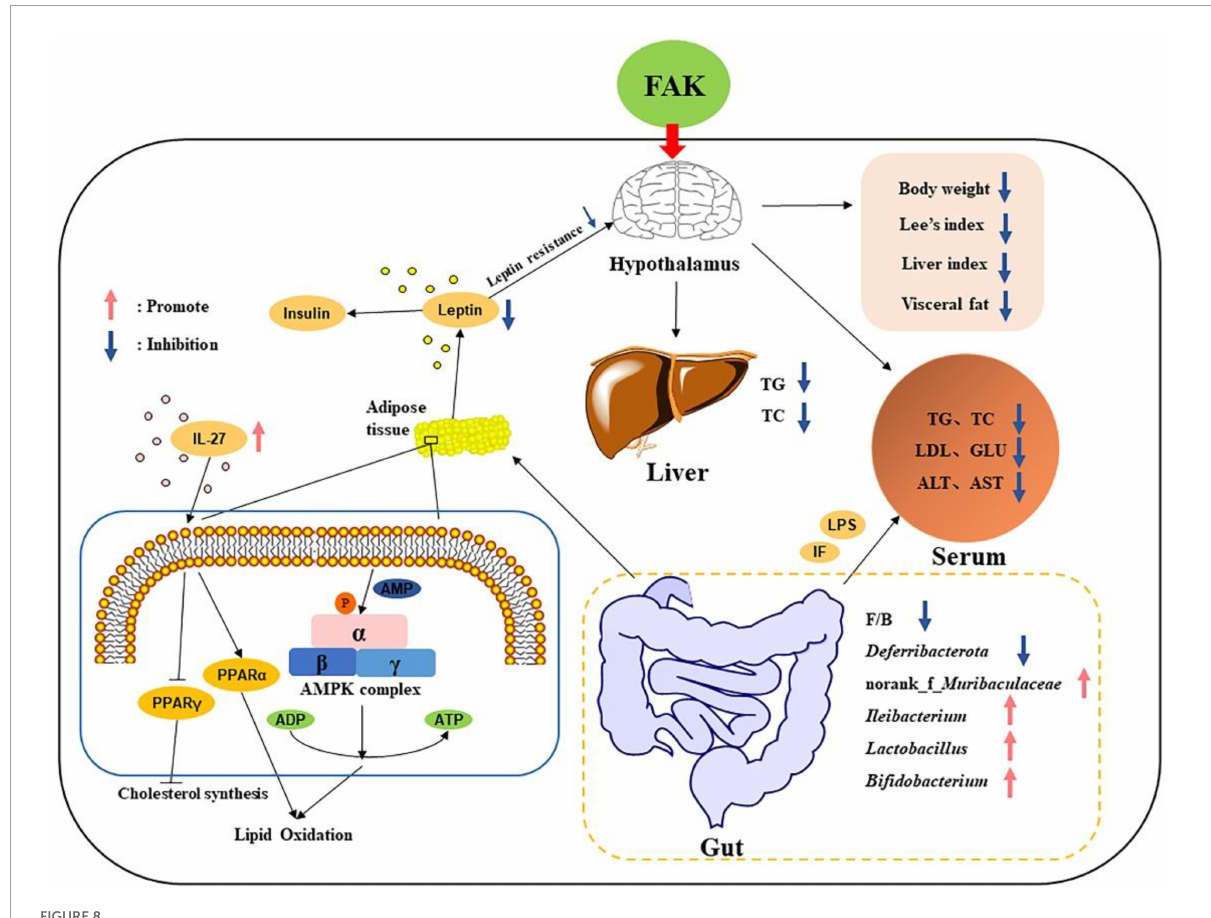
FIGURE8 Potential mechanisms by which FAK ameliorates HFD-induced